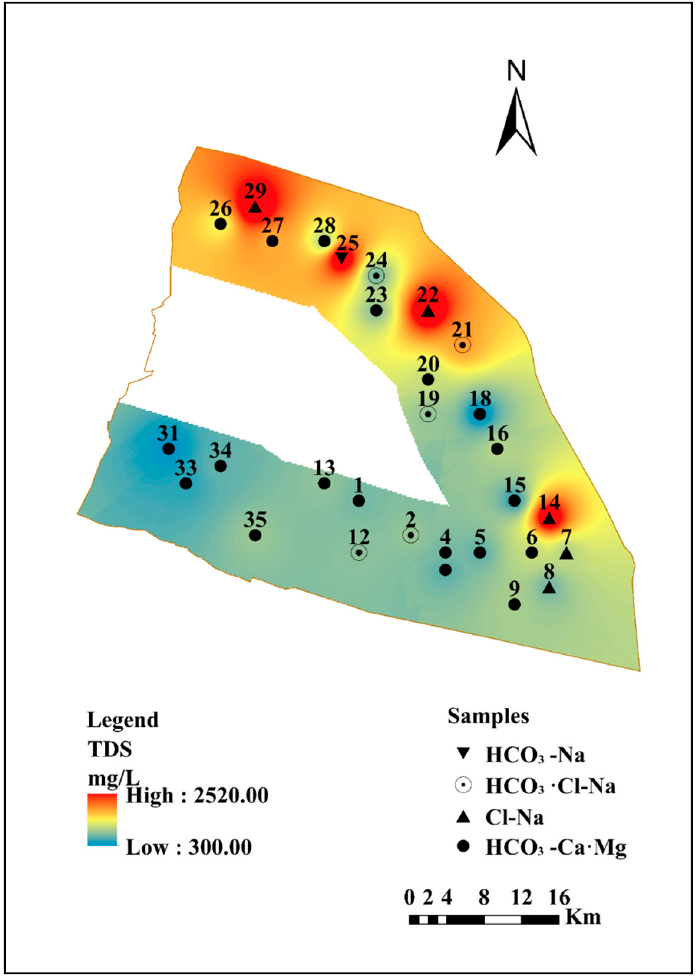
Figure 3. Geospatial distribution of TDS in the study area.